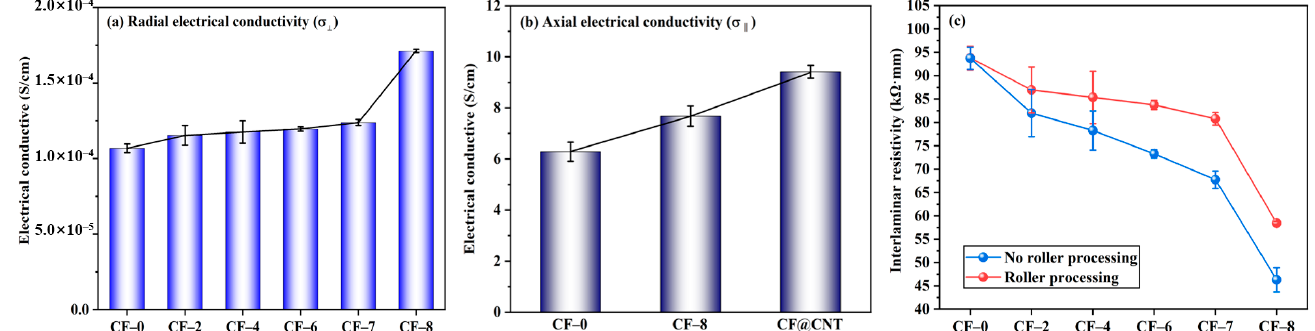
Figure 5. Radial electrical conductivity σ ⊥ of multilayer CF@(CNT/Fe 3 O 4 )/EP-CFs composite ( a ), axial electrical conductivity σ ‖ comparison of CF, CF@ (CNT/Fe 3 O 4 ) and CF@CNT composite ( b ), interlaminar resistivity comparison of roll treatment ( c ).